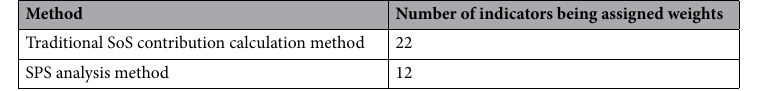
Table 1. The difference of the number of indicators being assigned weights between traditional SoS contribution calculation method and SPS analysis